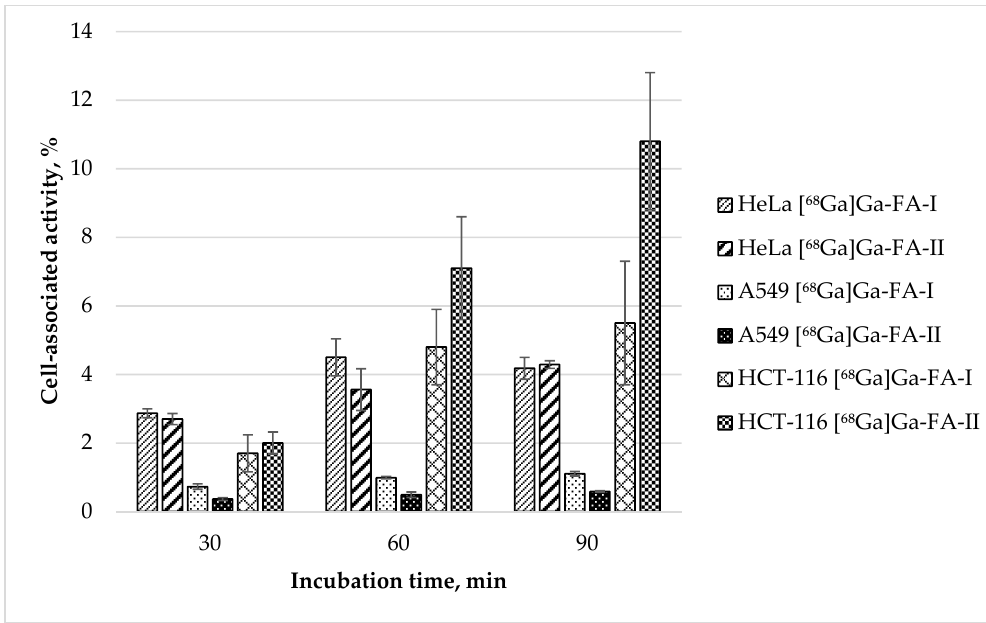
Figure 3. In vitro accumulation of [ 68 Ga] Ga-FA-I and [ 68 Ga] Ga-FA-II in HeLa, A549 and HCT-116 cell cultures ( mean ± SD, n = 3 ).